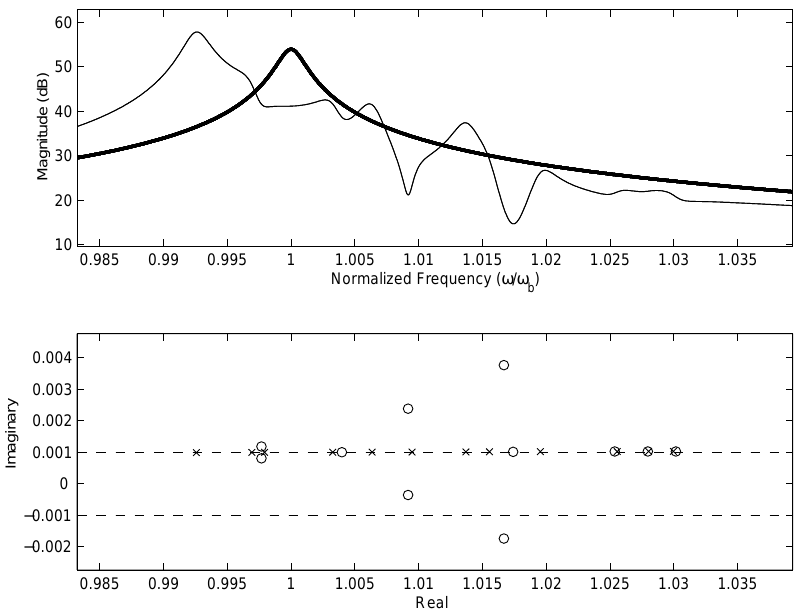
Fig. 5. Response to Engine Order N. a) maximum Blade FRF ( A = 1 . 56 ). — tuned, — mistuned. b) Pole/Zero Map. × poles, ◦ zeros. Zeros between the dashed lines reduce the response more than the poles amplify